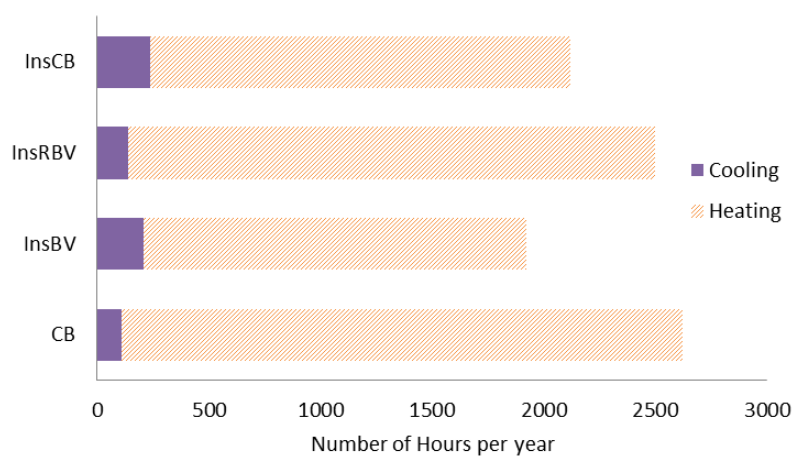
Fig. 8. Number of hours where cooling or heating required for each module using adaptive thermal